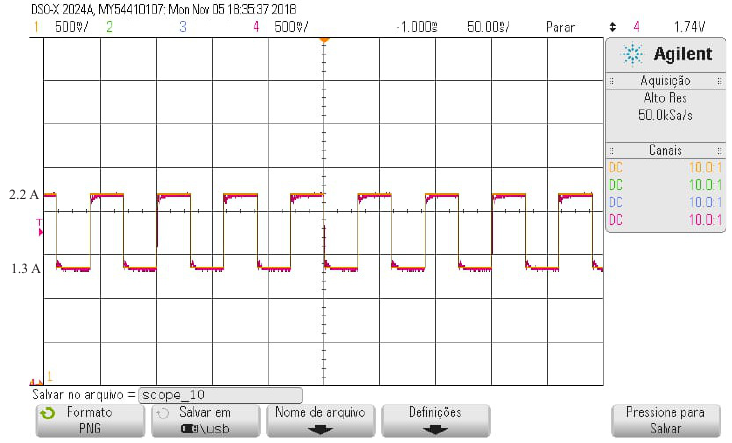
Figure 8. Response of the SMPI for a square reference profile of